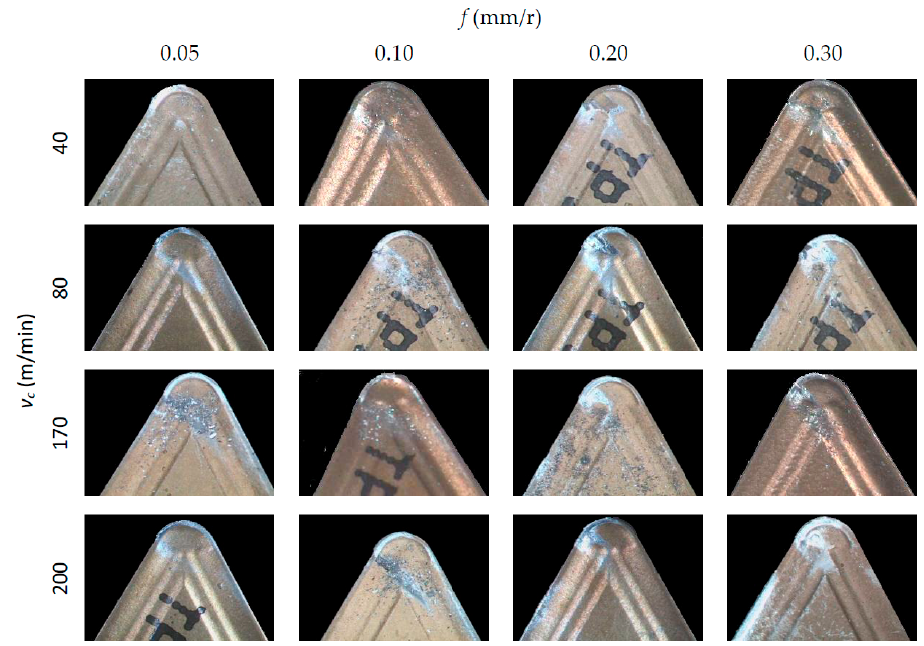
Figure 4. SOM images (30×) of the rake face, for a p = 0.5 mm.